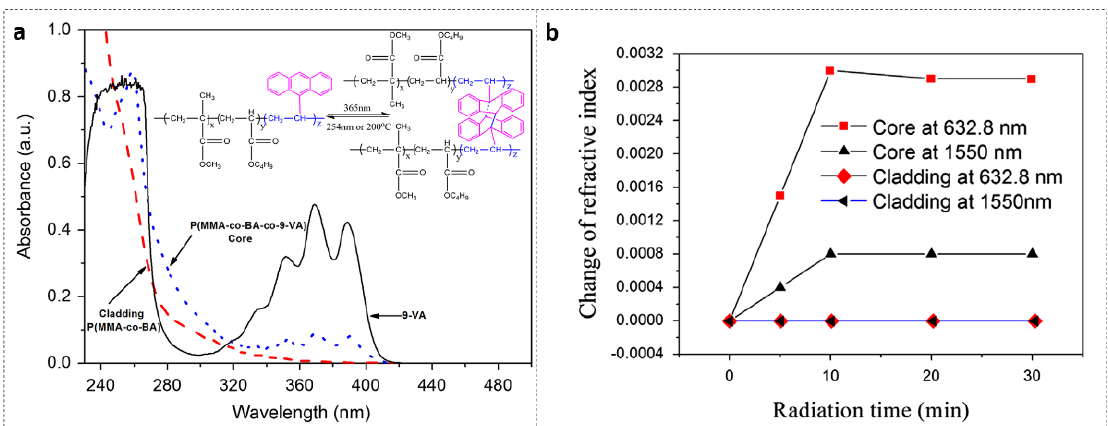
Figure 5. ( a ) Absorption spectra of cladding material [P(MMA ‐ co ‐ BA)] (dashed line), core material [P(MMA ‐ co ‐ BA ‐ co ‐ 9 ‐ VA)] (dotted line) and pure 9 ‐ VA (solid line); The inset presents the reaction of photo ‐ crosslinking and dissociation under 365 nm UV irradiation. Reprinted with permission from [30]. ( b ) The refractive index changes of core and cladding materials under 365 nm UV irradi ‐ ation as a function of time. Reprinted with permission from [30].